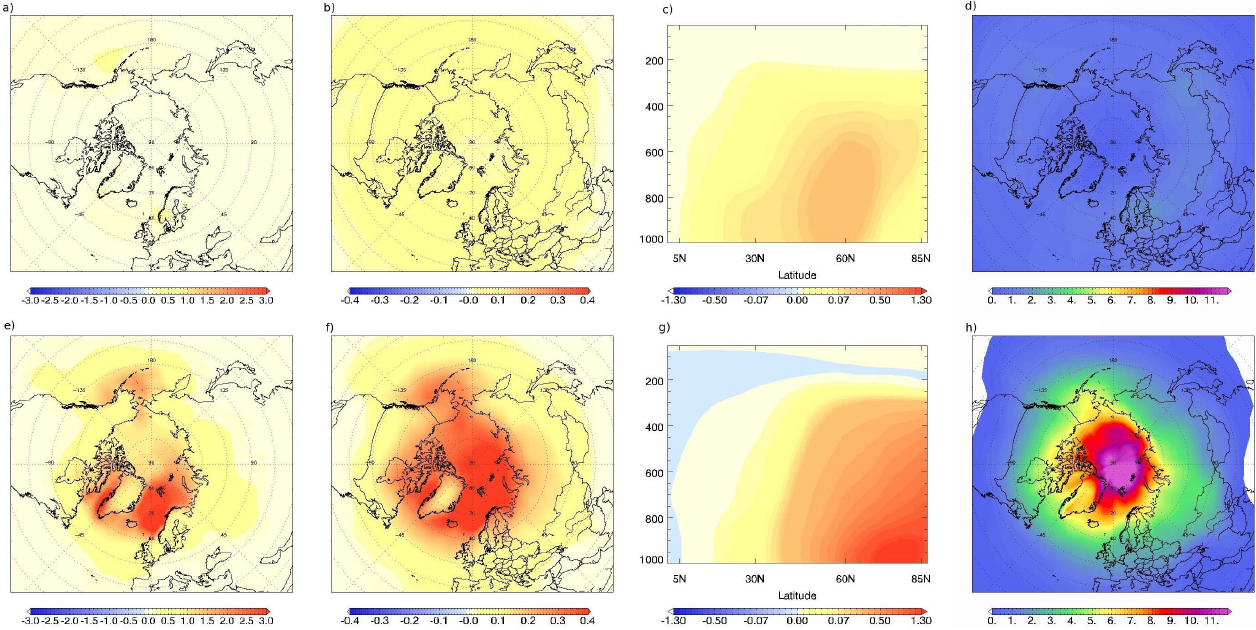
Fig. 3. O 3 effects from Arctic shipping emissions. Top panel ( a , b , c and d ) are responses from shipping activity in January-February-March, while lower panel ( e , f , g and h ) are responses for July-August-September mean. ( a and e ) Seasonal mean contribution to surface O 3 [ppb]. ( b and f ) Seasonal mean impact on tropospheric O 3 column [DU]. ( c and g ) Seasonal zonal mean O 3 [ppb]. ( d and h ) Radiative forcing [mWm − 2 ] due to the ozone